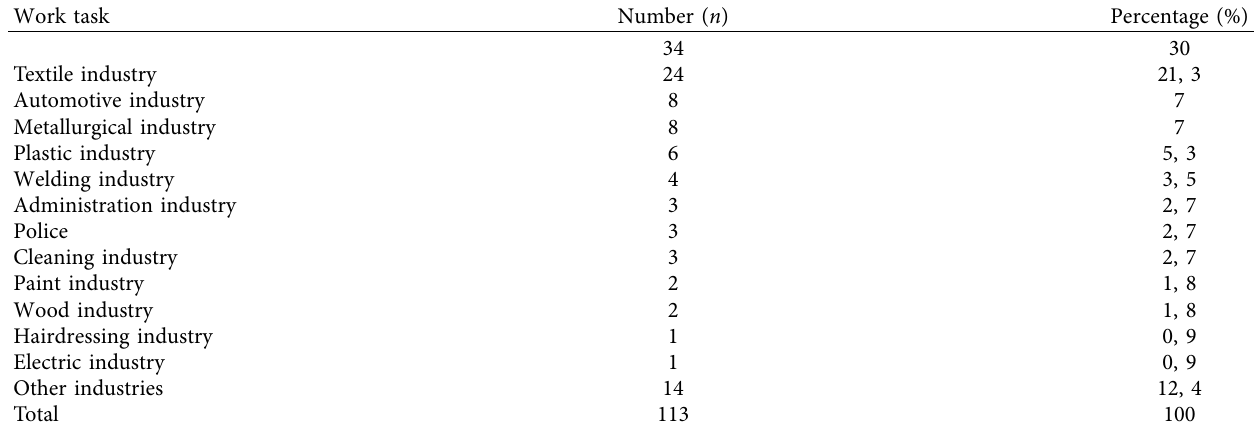
Table 1: Distribution of the study population according to work tasks.